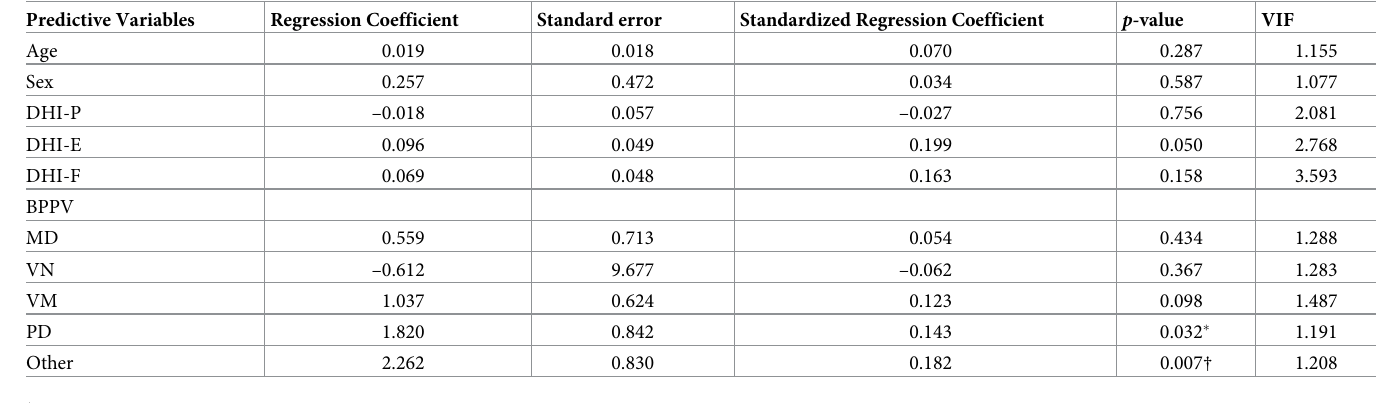
Table 4. Multiple regression analyses of PSQI (a) in relation to subscales of DHI, age, sex, and all groups. Predictive Variables